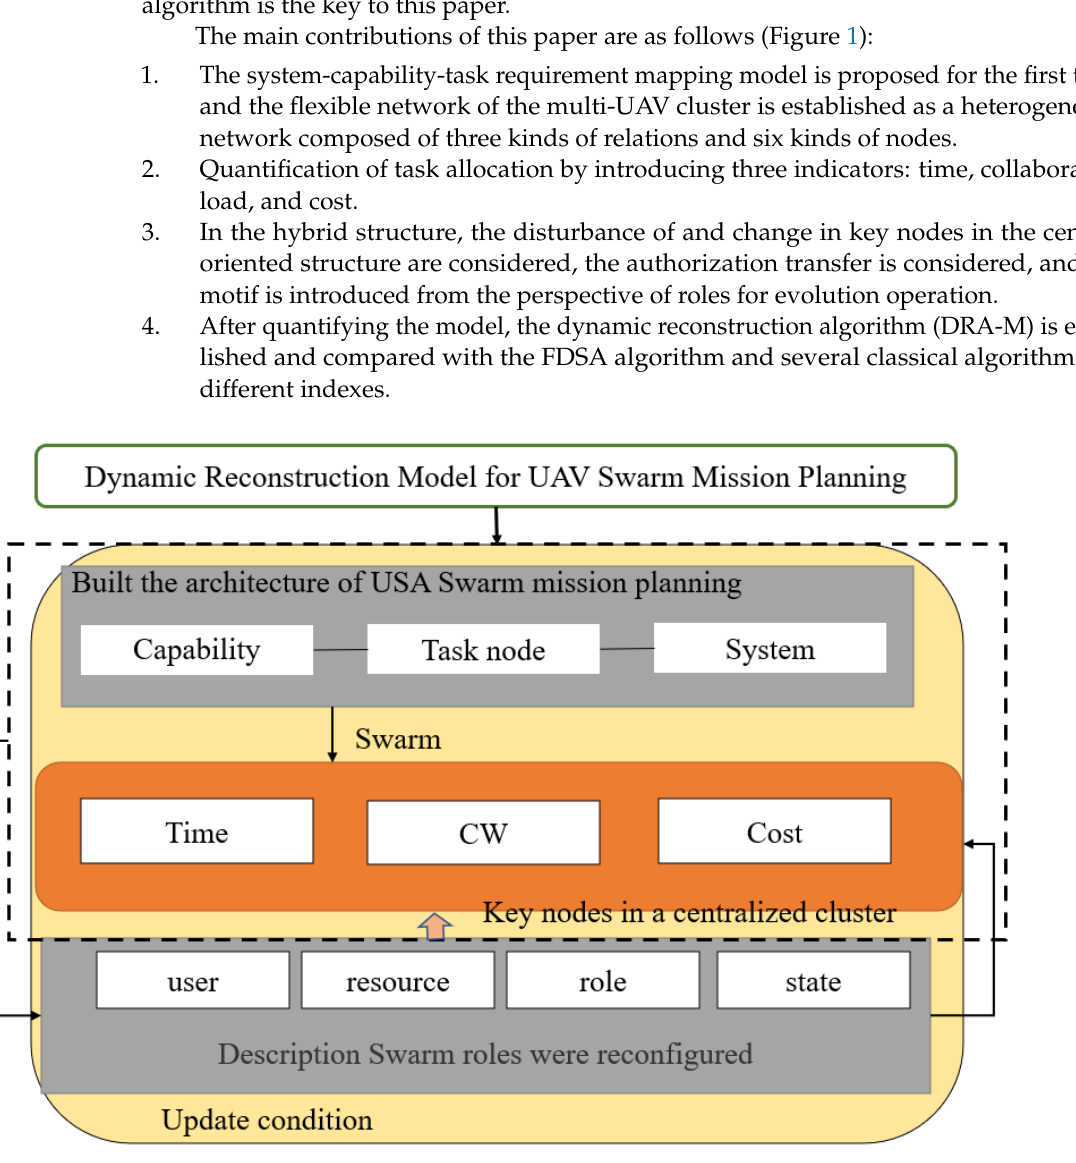
Figure 1. The main organizational structure of the